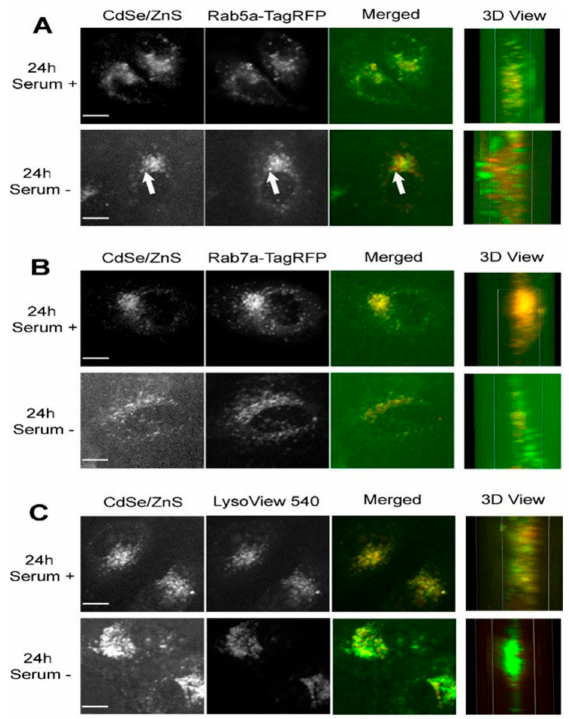
Figure 4. Representative confocal microscope images depicting subcellular localizations of green CdSe/ZnS-COOH QDs after 24 h treatment with QDs in HeLa cell culture. ( A , top ) Colocalization of the early endosome reference marker Rab5a-TagRFP with the QDs in the presence of serum. ( A , bottom ) Partial colocalization of QDs with Rab5a-TagRFP in cells grown in the medium lacking serum. The arrow indicates a spatial area of no colocalization between QDs and Rab5a-TagRFP. ( B , top ) Colocalization of the late endosome reference marker Rab7a-TagRFP with the QDs in the presence of serum. ( B , bottom ) Colocalization of QDs with Rab7a-TagRFP in cells grown in the medium lacking serum. ( C , top ) Colocalization of the lysosome reference marker LysoView 540 with the QDs in the presence of serum. ( C , bottom ) Colocalization of QDs with LysoView 540 in cells grown in the medium lacking serum. Scale bars correspond to 10 µ